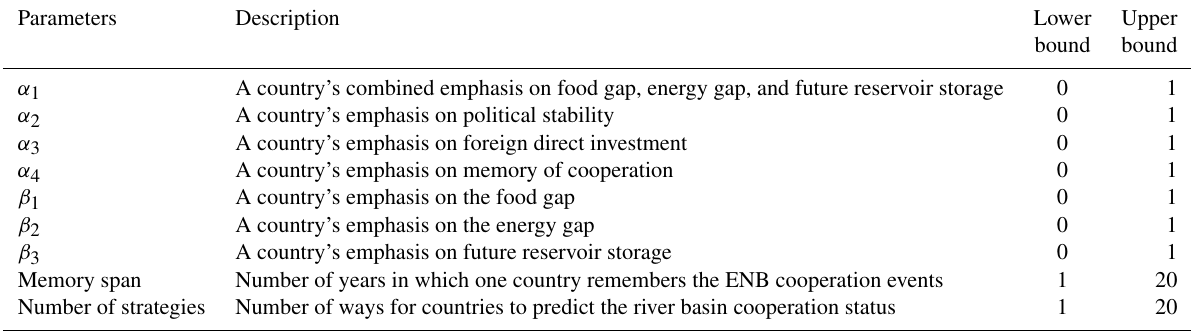
Table 2. Parameters varied in the sensitivity analysis and their lower and upper bounds of the Eastern Nile Basin Socio-hydrological (ENSH) model. All parameters are unitless.